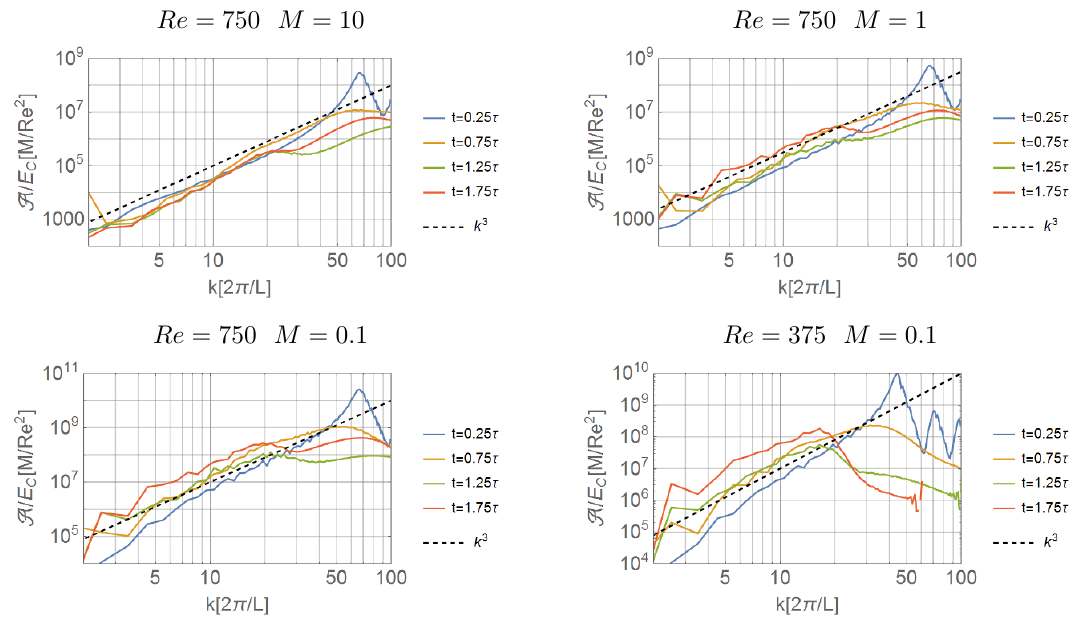
Figure 21 . A ( t; k ) =E C ( t; k ) for three dimensional turbulent (cid:13)ows with initial mode n = 1 at intermediate times. The dashed line corresponds to a k 3 behavior.